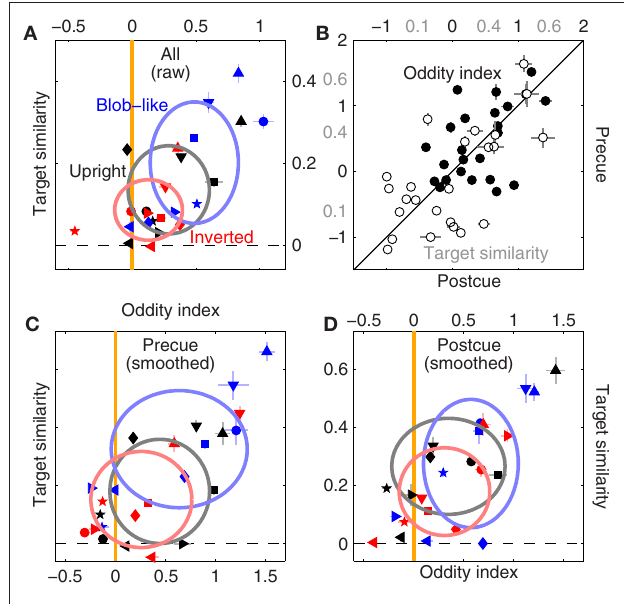
Figure 10 | Filter shape metrics for phase-only images. (A) Is the equivalent of Figure 5C , (B) is the equivalent of Figure 7C , (C,D) are the equivalent of Figures 7A,B ; all report data for the phase-only manipulation as opposed to the original unmanipulated images.